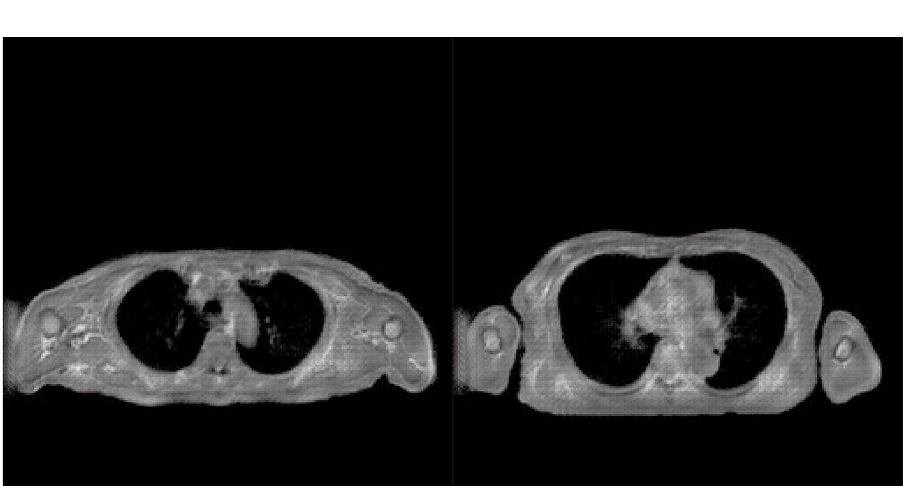
Figure 12. CT images synthesised using CycleGAN + MIND with high MIND loss